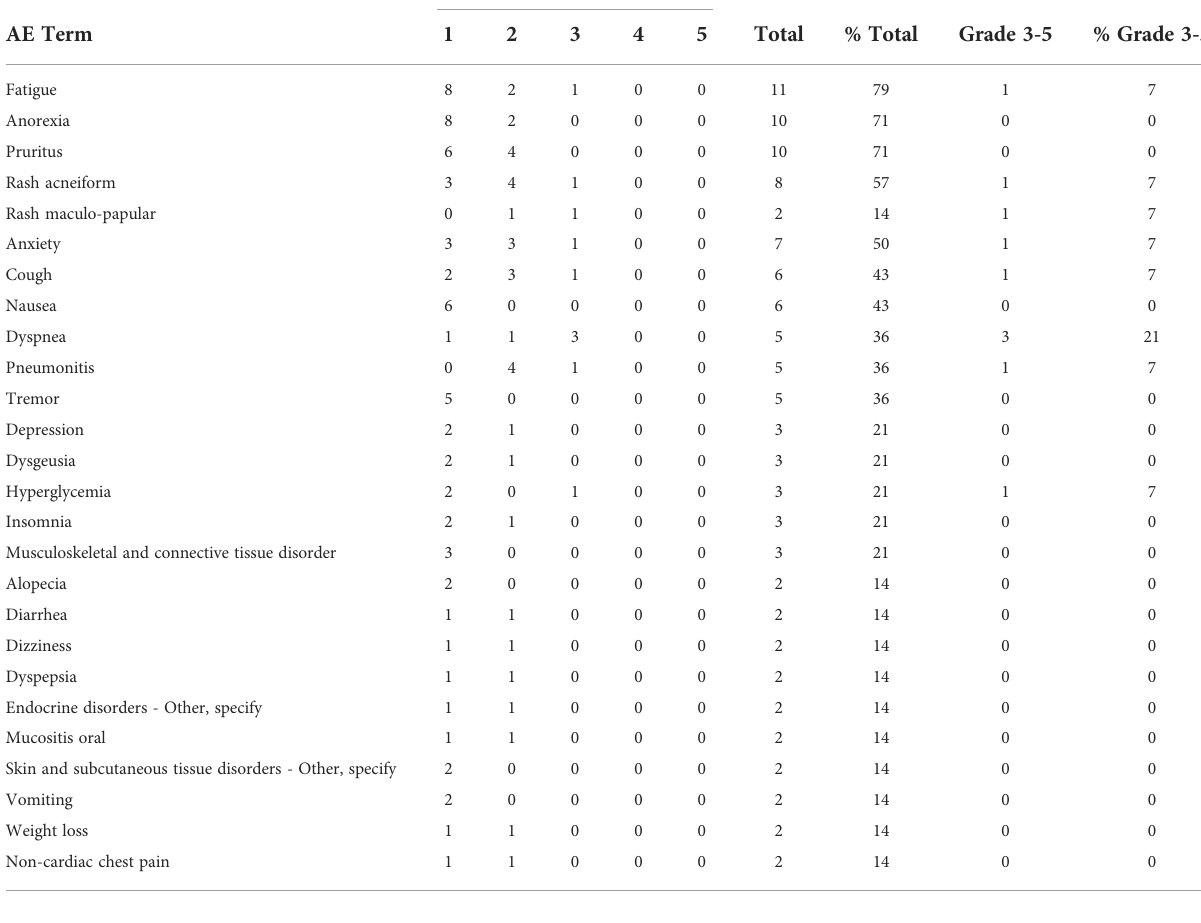
TABLE 2 Treatment Related Adverse